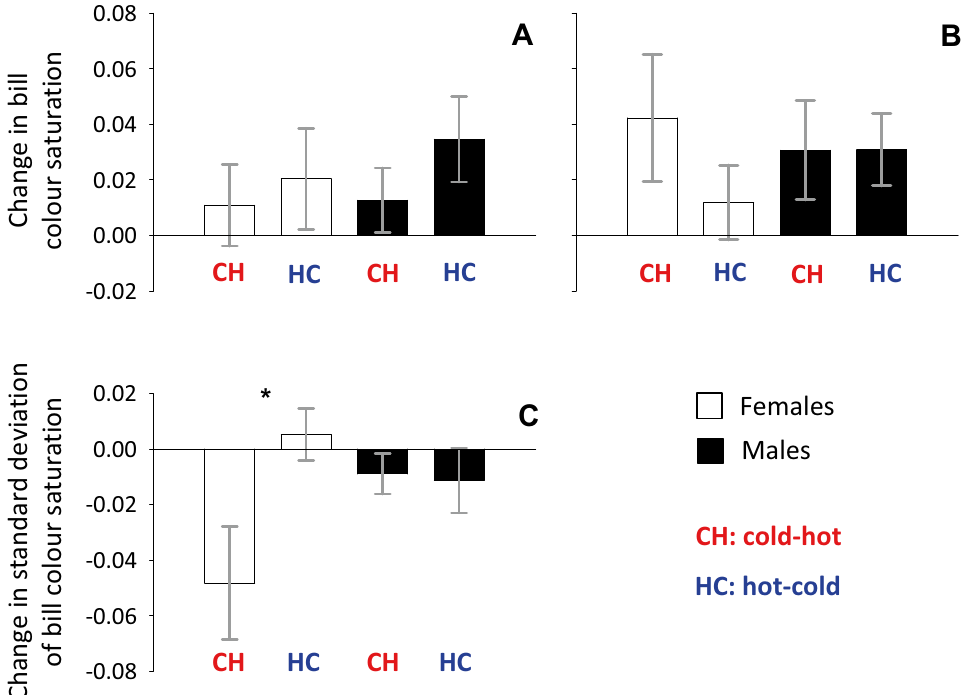
Figure 4. Changes in bill colour saturation (means ± SE) using data from ( A ) the entire 4-week periods of temperature manipulations, or ( B ) the last 2 weeks of each 4-week period temperature manipulations. ( C ) Changes in the standard deviation of bill colour saturation. CH cold–hot treatment, HC hot–cold treatment. Asterisks mark statistically significant differences between